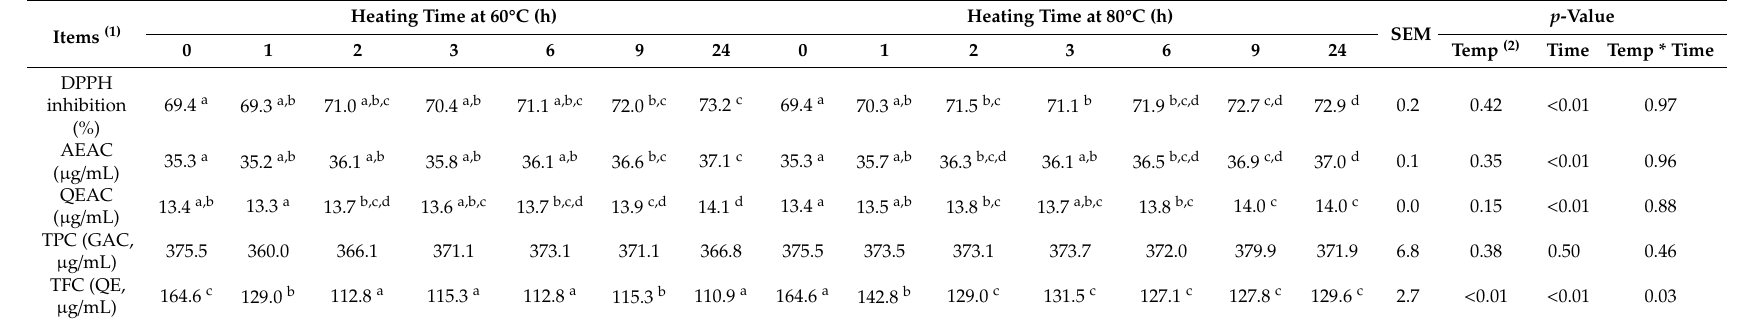
Table 3. Variations in the antioxidant activity of the CC juice subjected to heat